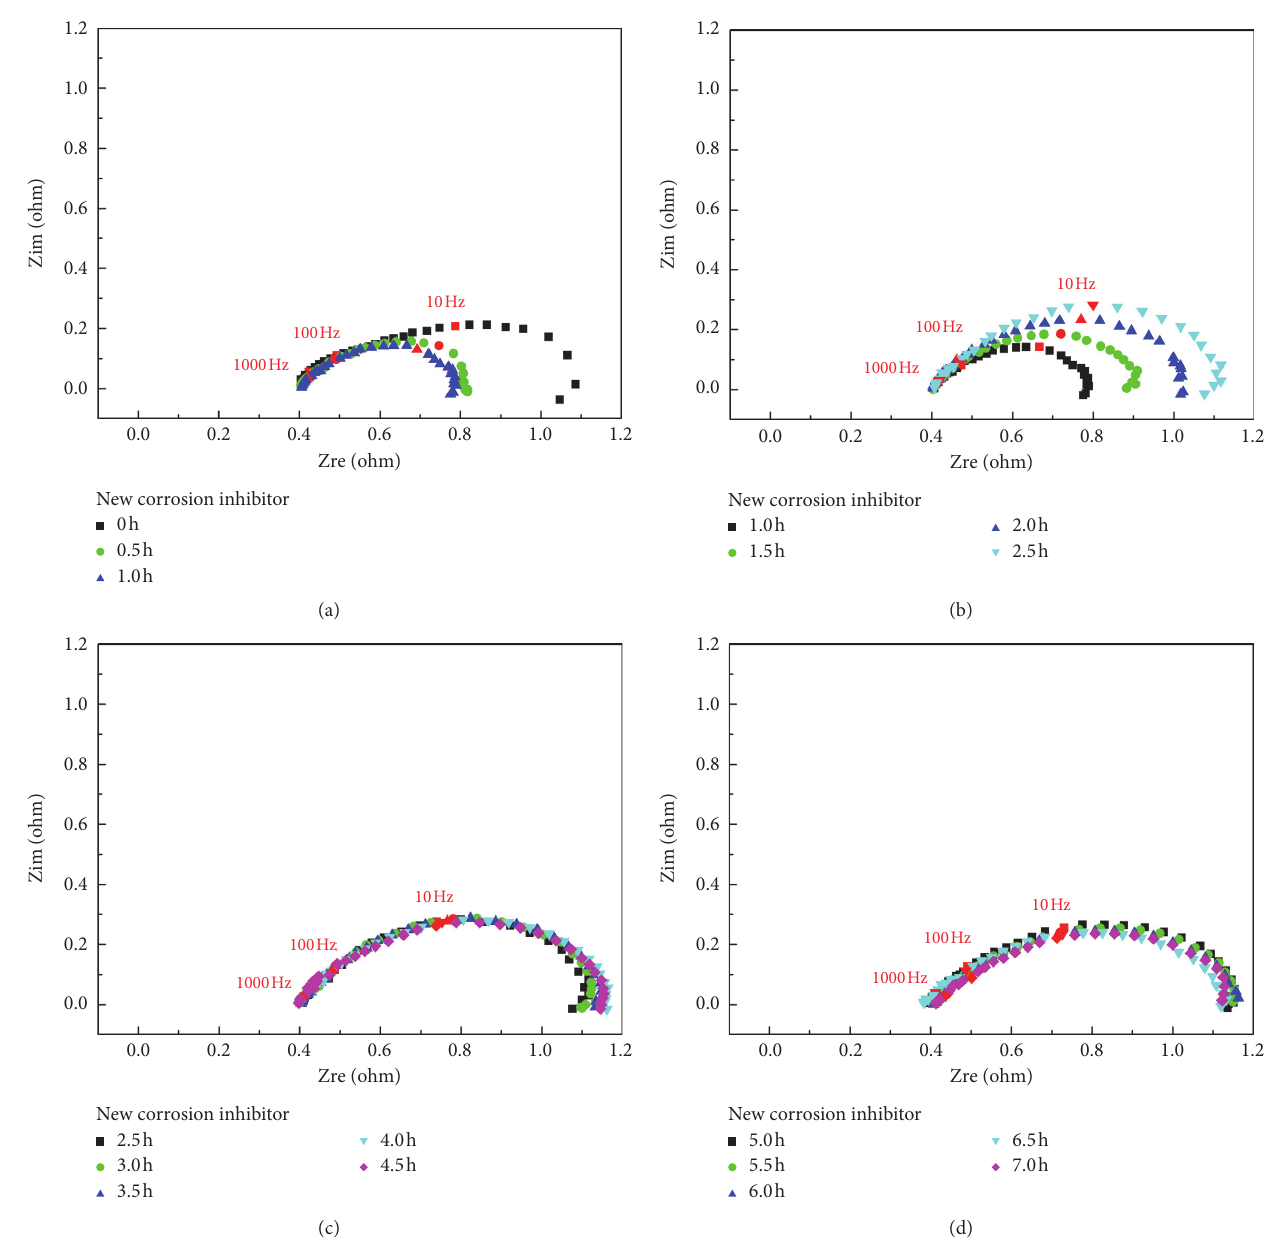
Figure 8: Nyquist diagrams at different times under the condition of adding new corrosion inhibitor: (a) 0–1.0 h. (b) 1.0h–2.5h. (c) 2.5h–4.5h. (d)